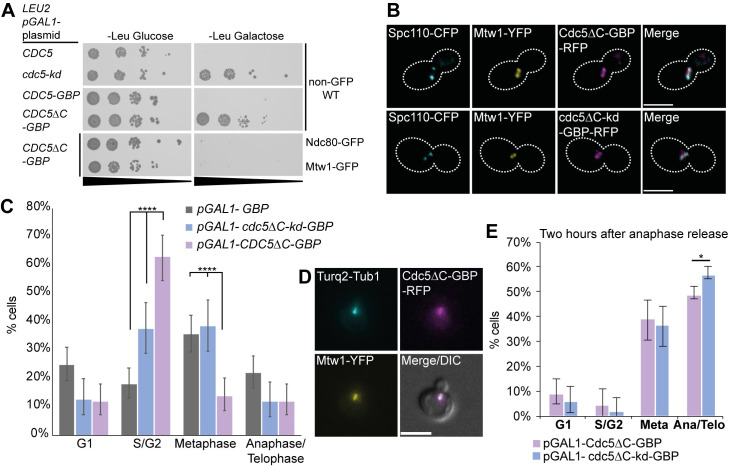
Forcing Cdc5 association with Mtw1 disrupts cell-cycle progression prior to mitosis.(A) 10-fold serial-dilution spot assay shows that pGAL1-driven expression of CDC5 in wild-type (WT) cells is lethal on galactose containing media whereas CDC5ΔC-GBP is not. However, expressing CDC5ΔC-GBP in GFP-tagged kinetochore strains (Mtw1 and Ndc80) is lethal. (B) Live imaging of cells containing Mtw1-YFP and Spc110-CFP (PT257) and expressing Cdc5ΔC-GBP-RFP (or cdc5ΔC-kd-GBP-RFP) shows that Cdc5-GBP sufficiently colocalizes with YFP foci and also between two SPB foci confirming kinetochore localization. Note that GBP does not have an affinity for CFP. Scale bar represents 5μm. (C) Cell-cycle analysis of Mtw1-YFP cells (T607) containing mTurquoise2-tagged tubulin (Turq2-Tub1) was performed using fluorescence microscopy. Cells from asynchronous cultures containing pGAL1-CDC5ΔC-GBP (n = 153), pGAL1-cdc5ΔC-kd-GBP (n = 120) or pGAL1-GBP (n = 219) were imaged after 4 hours of growth in 2% galactose media to induce expression. Cells that did not show RFP/YFP colocalization were excluded from this analysis. Cells expressing Cdc5ΔC-GBP-RFP were significantly increased in S/G2 phase compared to controls. Fishers exact statistical test; p-values **** = p < 10−4. Error bars indicate 95% binomial confidence intervals (C.I.). (D) Representative cropped image from the analysis in (C) showing a CDC5ΔC-GBP expressing cell in S/G2-phase. Scale bar represents 5μm. (E) Mtw1-YFP cells expressing CDC5ΔC-GBP (n = 319) during mitosis are able to progress into anaphase/telophase although at a slightly lower frequency than cells expressing cdc5ΔC-kd-GBP (n = 211). The metaphase-arrested cells in S5B Fig were released into anaphase by resuspending the cell cultures in galactose media lacking methionine. Two hours after release the cell-cycle stage of these cells was analyzed and revealed that about half of the cells had progressed into anaphase/telophase. Statistical analysis was done using Fishers exact test; p-values * = p < 0.05. Error bars indicate 95% binomial C.I.